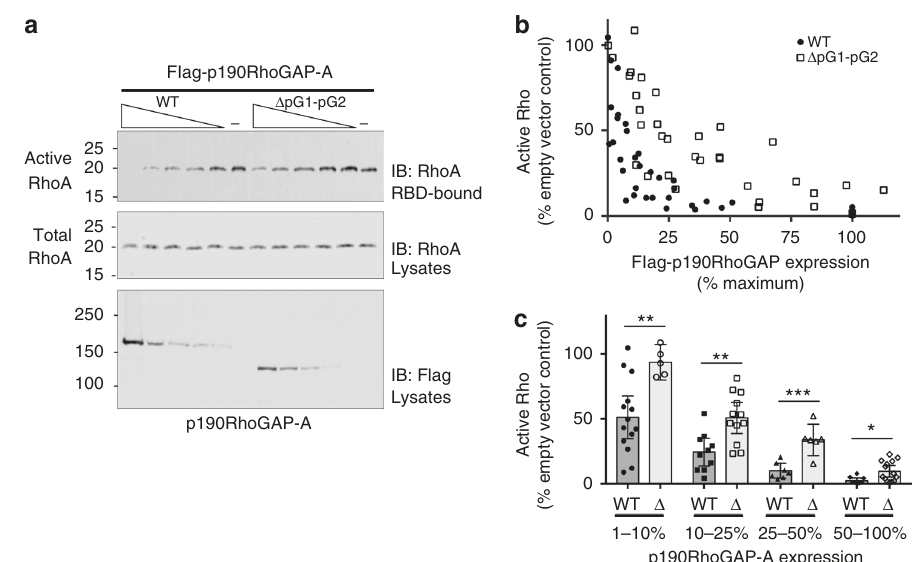
Fig. 5 Rho activation assays. a Active endogenous RhoA levels assessed by pulldown with a GST-rhotekin Rho binding domain (GST-RBD) from HEK293T cells transfected with a gradient of Flag-p190RhoGAP-A, pG1-pG2 deletion mutant ( Δ pG1 – pG2), or empty Flag vector ( − ). A representative set of immunoblots is shown. b Scatter plot of active RhoA as a function of Flag-p190RhoGAP expression. Active RhoA is normalized to maximum levels in each experiment (empty vector control) and Flag-p190RhoGAP expression as a percentage of maximum expression within each experiment. Shown is the compilation of data from 8 independent experiments. c Scatter/bar plot of data from ( b ), with data points binned according to Flag-p190RhoGAP expression as indicated (1 – 10%, 10 – 25%, 25 – 50% and 50 – 100%). The mean and s.e.m. ( error bars ) of each group is shown. Unpaired t -tests (two-tailed) were performed in GraphPad Prism, with statistical signi fi cance indicated above pairs and p- values as follows: 1 – 10% bin p = 0.0053; 10 – 25% bin p = 0.0019; 25 – 50% bin p = 0.0006; and 50 – 100% bin p = 0.0133